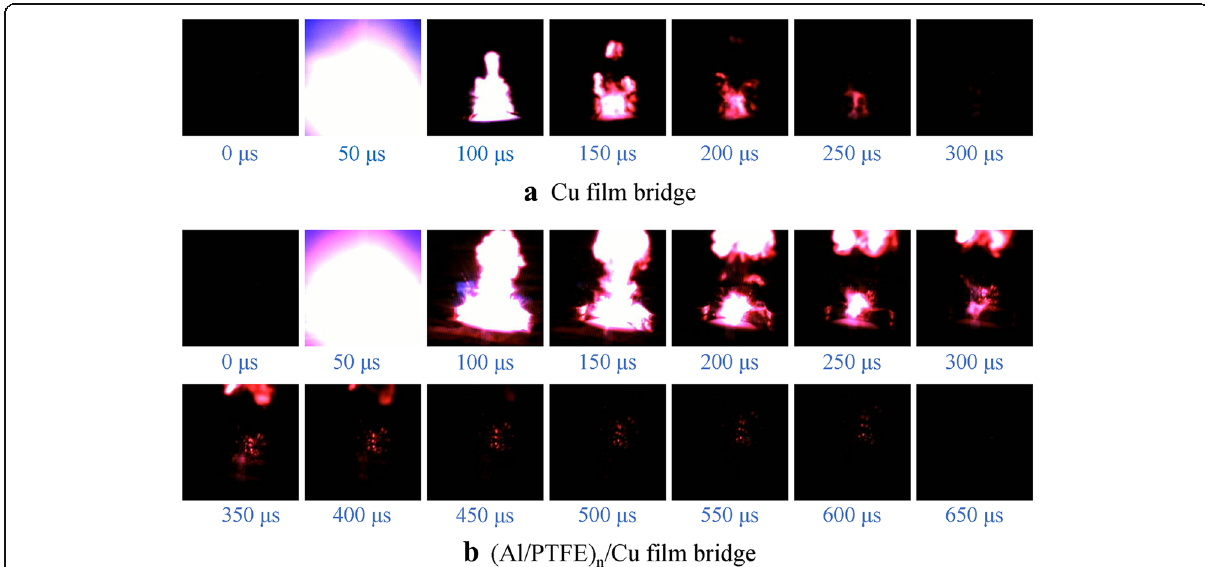
Fig. 5 High-speed camera observation of the electric explosion processes for the Cu film bridge ( a ) and the (Al/PTFE) n /Cu film bridge ( b ) at a 2500-V discharge